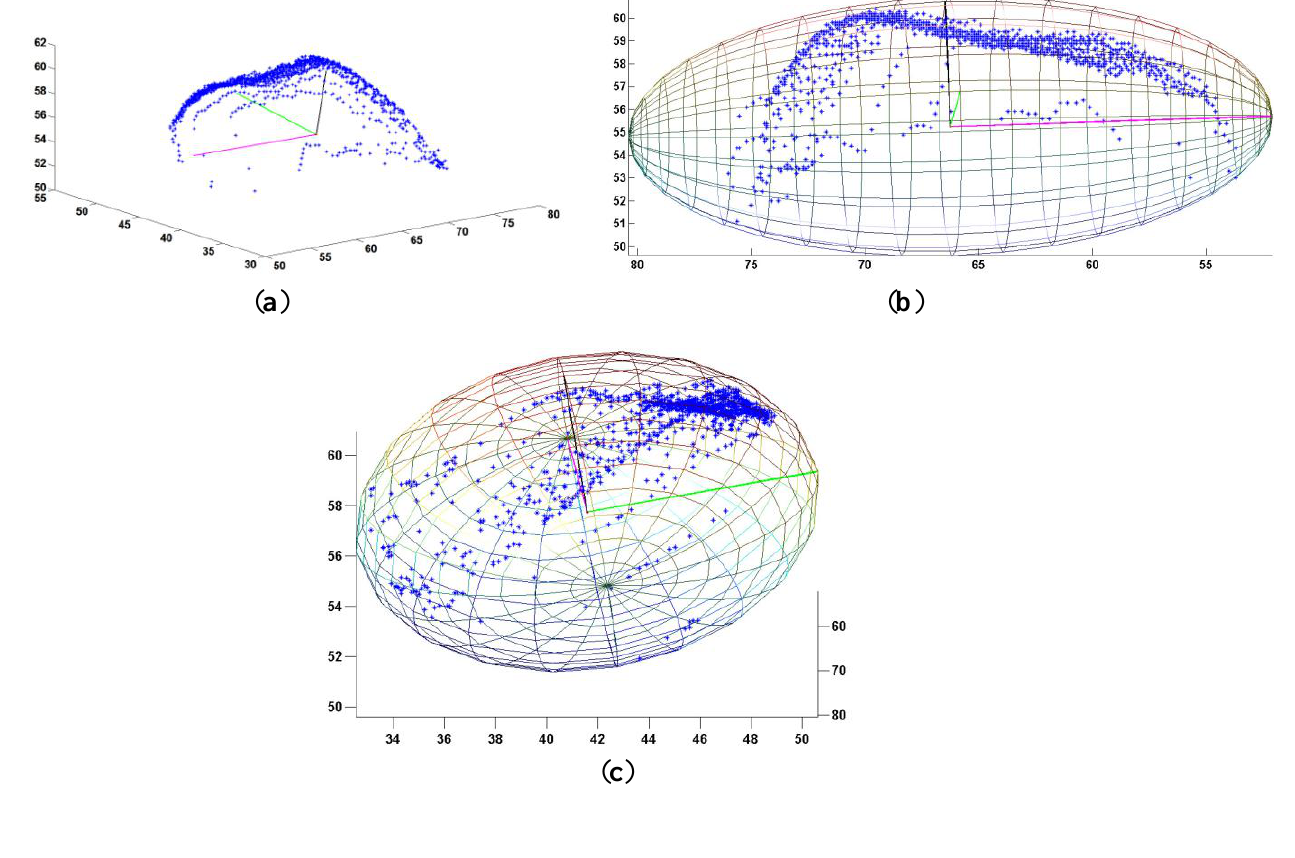
Figure 8. ( a ) MLS points of a cobble and the 3 axes of its minimum volume enclosing ellipsoid (MVE). ( b ) Points and MVE projected in MVE’s a (magenta) and b (black) axis plane. ( c ) Points and MVE projected in the (y, z) plane. MLS points displayed in a local coordinate system, the scalar unit in (a–c) is in